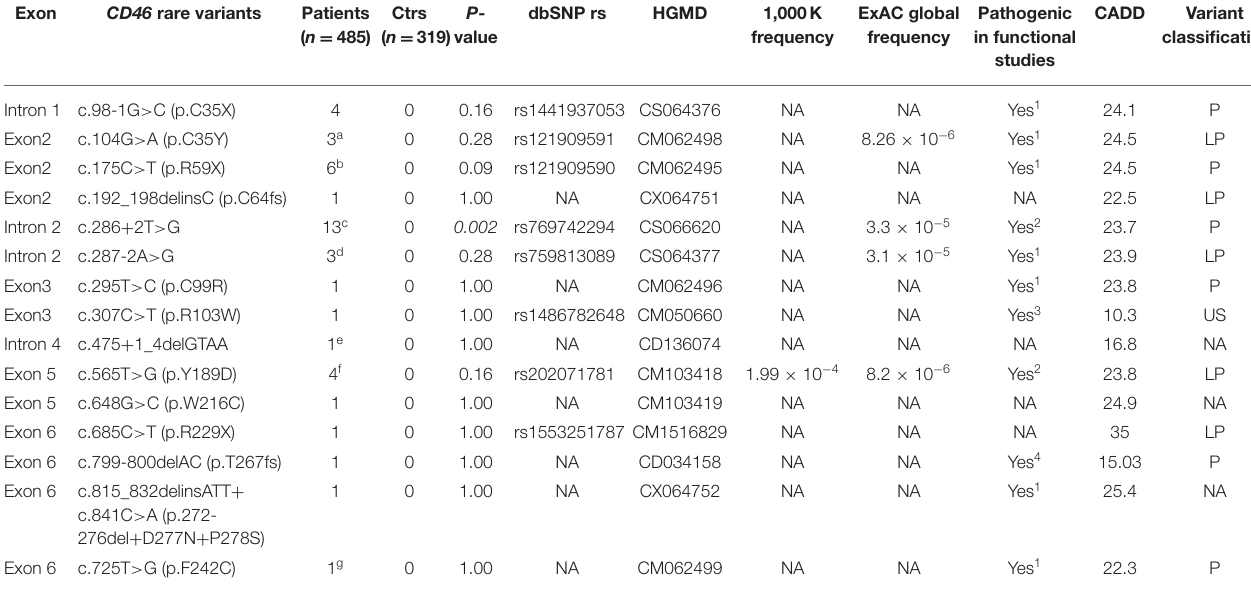
Pathogenic in functional